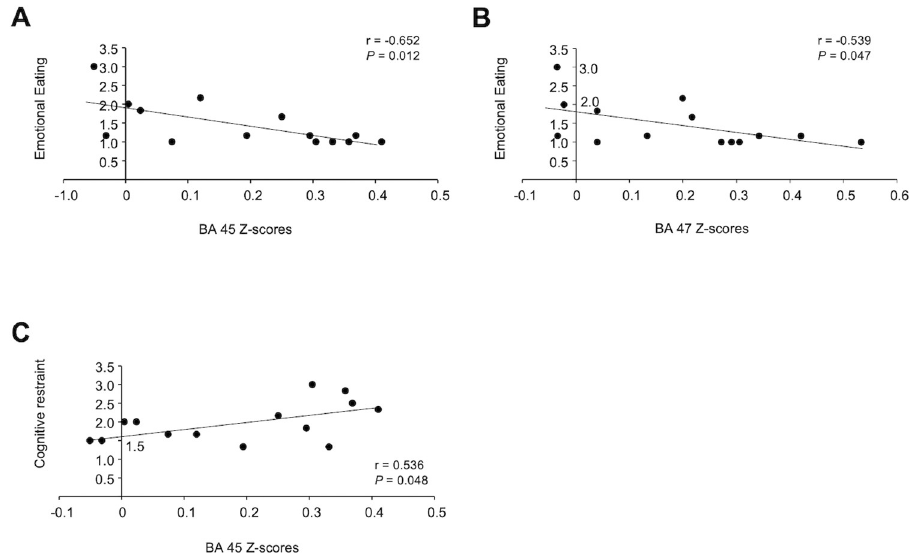
Fig 4. Relationships between the indices of eating behavior and the extent to which the neural responses to the pictures in the visible condition was different from those in the invisible condition observed in BA 45 and 47. (A) Relationship between the level of emotional eating and the extent to which the neural responses to the pictures in the visible condition was different from those in the invisible condition observed in BA 45. (B) Relationship between the level of emotional eating and the extent to which the neural responses to the pictures in the visible condition was different from those in the invisible condition observed in BA 47. (C) Relationship between the level of cognitive restraint and the interaction observed in BA 45. The linear regression line, Pearson’s correlation coeffect, and P value are shown. The standardized values for the indices of emotional eating and cognitive restraint were used.